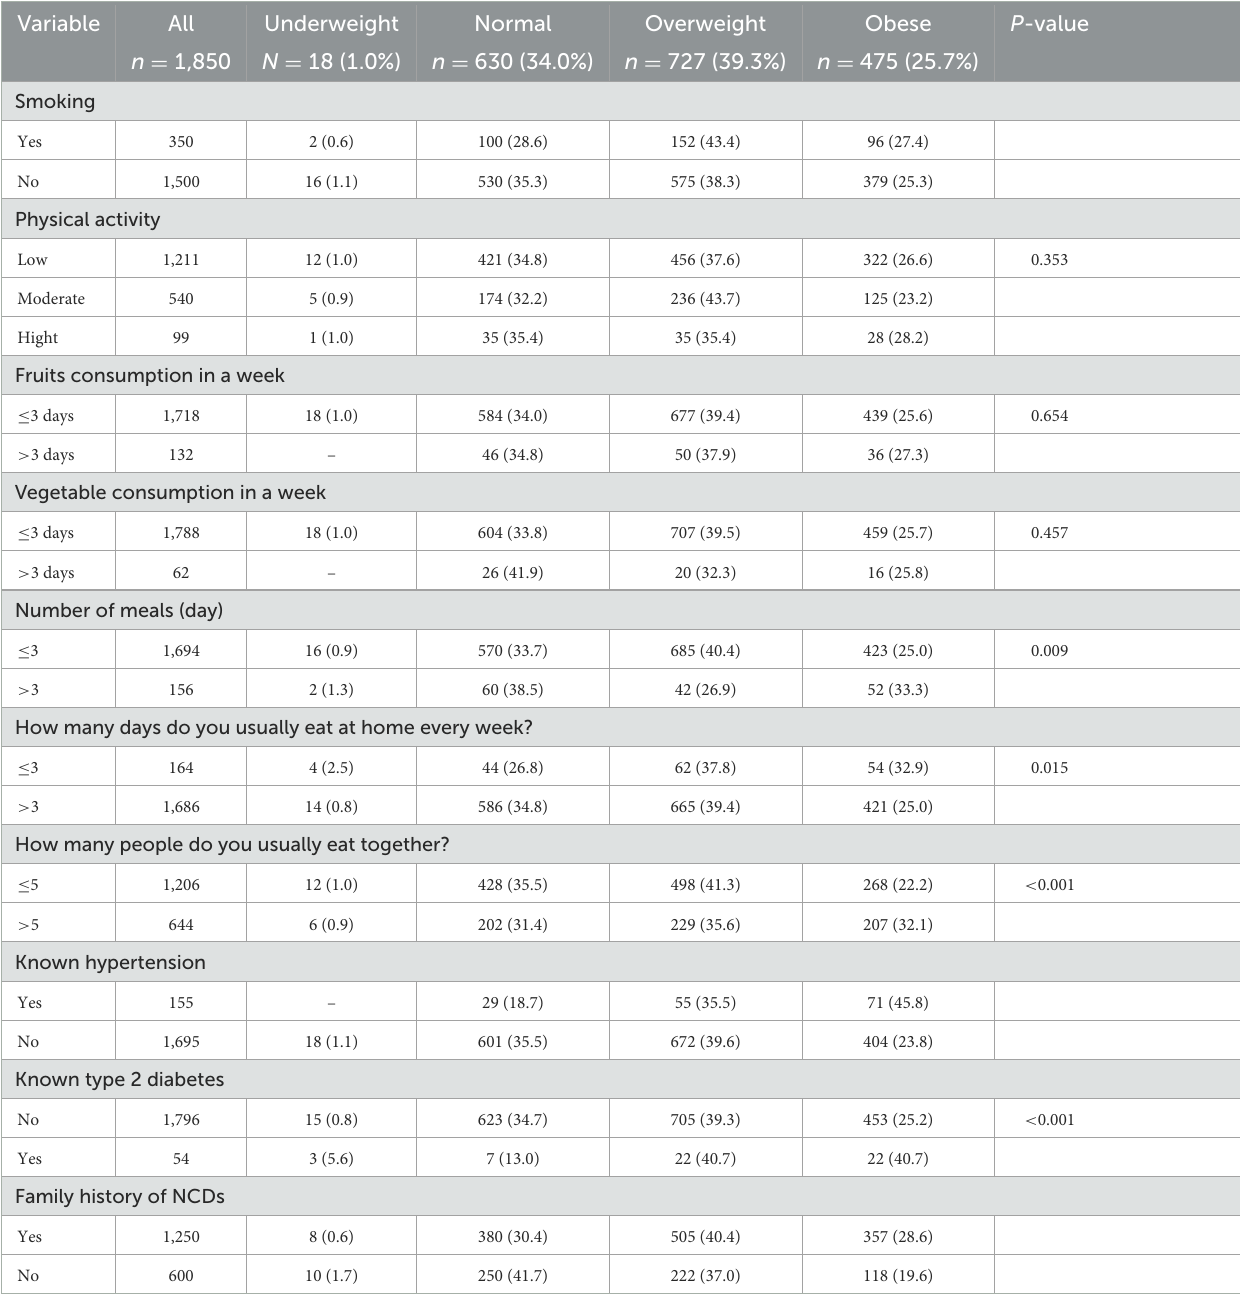
TABLE 2 Lifestyle factors and medical history of HCWs in the Gaza Strip by BMI category ( n = 1,850). Variable All Underweight Normal Overweight